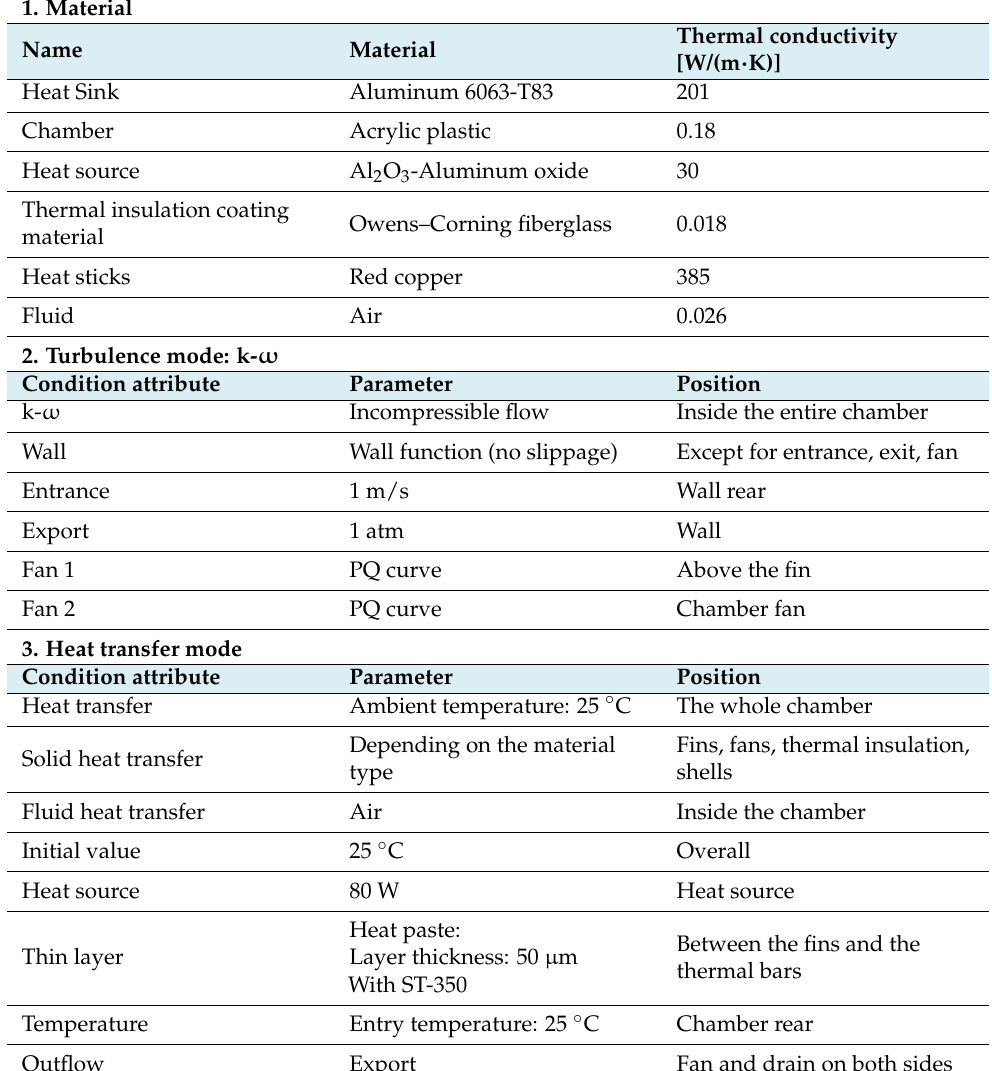
Table 1. Boundary circumstances